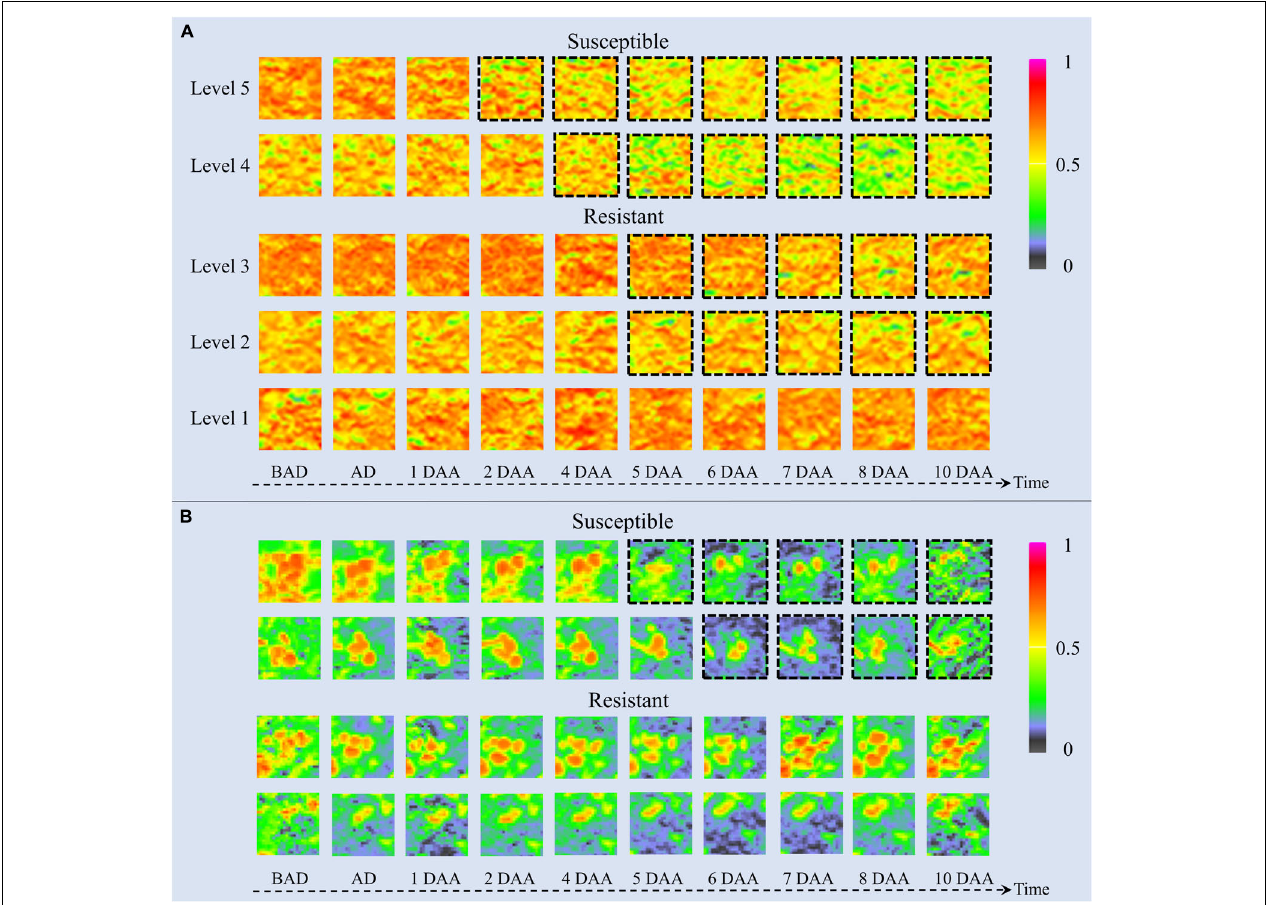
FIGURE 6 | UAV-based visualization of two weed species with dynamic changes in NDVI images. (A) Image patches of five resistance levels of barnyardgrass under herbicide stress, where dashed black borders around the patches indicate significant changes. (B) Image patches of two susceptible and two resistant velvetleaf under herbicide stress, where dashed black borders around the patches indicate significant changes. BAD is before application day; AD is application day; DAA is days after application.